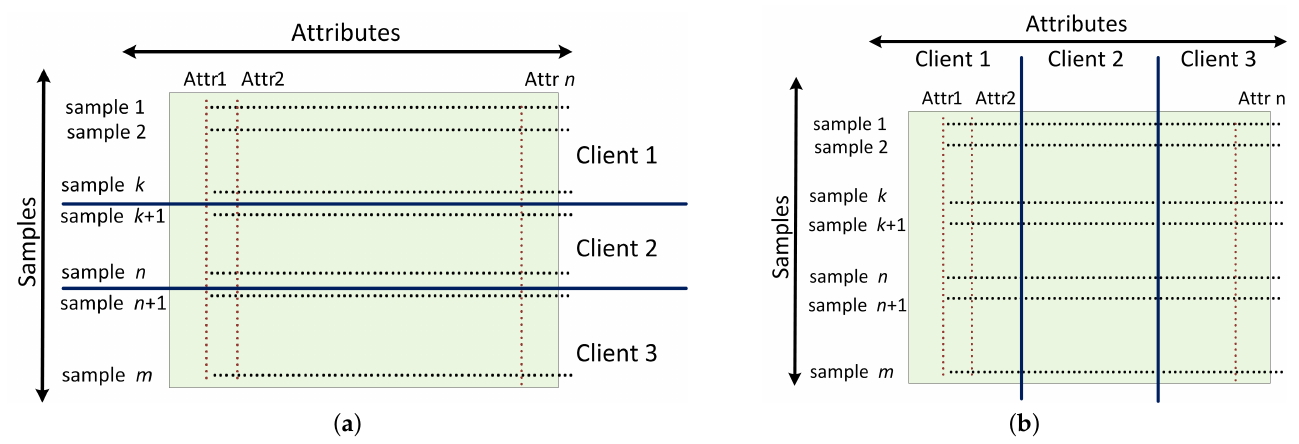
Figure 2. Types of the data partition: horizontally partitioned data ( a ), vertically partitioned data ( b